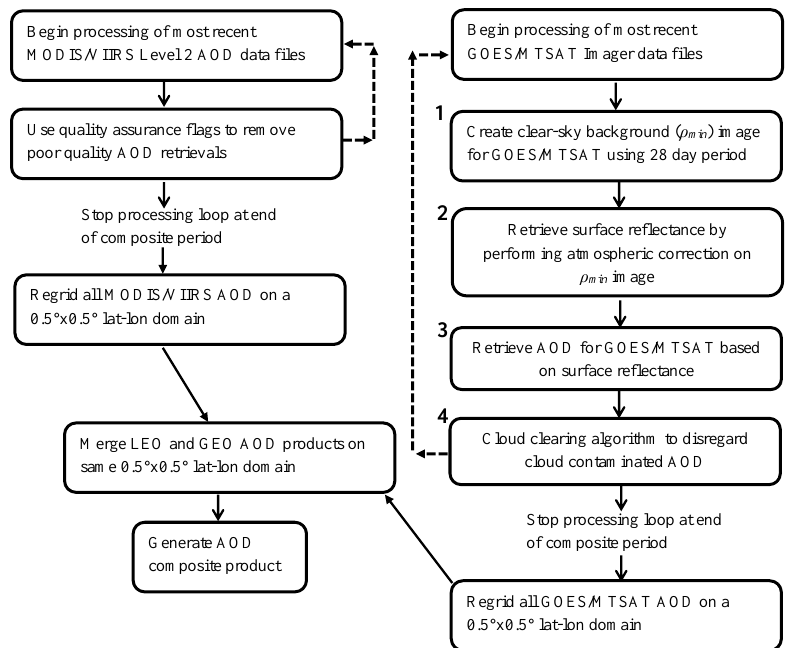
Figure 1. Schematic flow diagram of the steps involved in generating the NRT AOD composite product. The numbers 1–4 on the right-hand side of the schematic highlight the four major steps involved in the GEO AOD retrieval